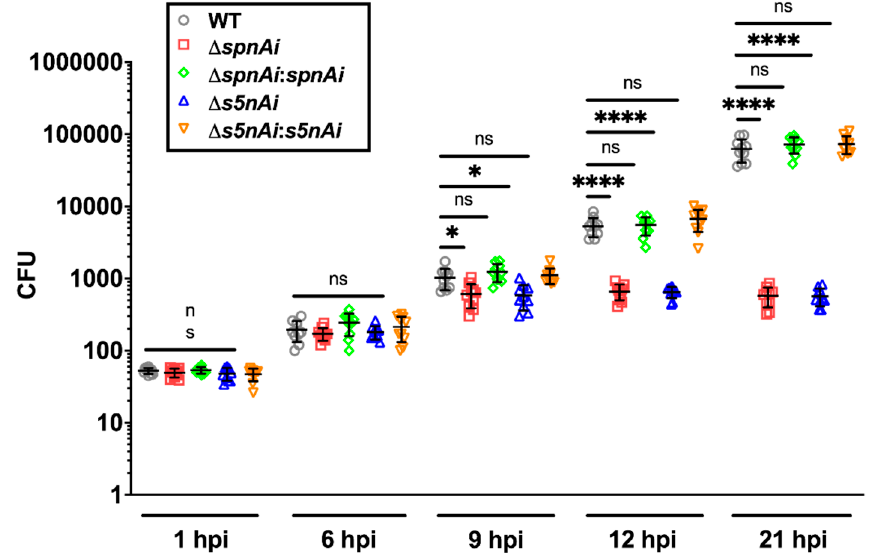
Figure 5. Bacterial load of zebrafish larvae infected with WT and mutant S. iniae strains. WT, ∆ spnAi , ∆ s5nAi and their complementation strains were each injected into 2 dpf larvae (wild-type AB line). The bacterial load of infected larvae ( n = 5 per group in each experiment) at indicated time-points were quantified by plating on kanamycin-containing THY + P agar plates. This data is the combined result from 2 independent experiments ( n = 5 per group in each experiment). The error bars show the standard deviation of two experiments. *, p < 0.05; ****, p < 0.0001; ns, not significant (as determined by a 2-way ANOVA with a Tukey’s multiple comparisons test).